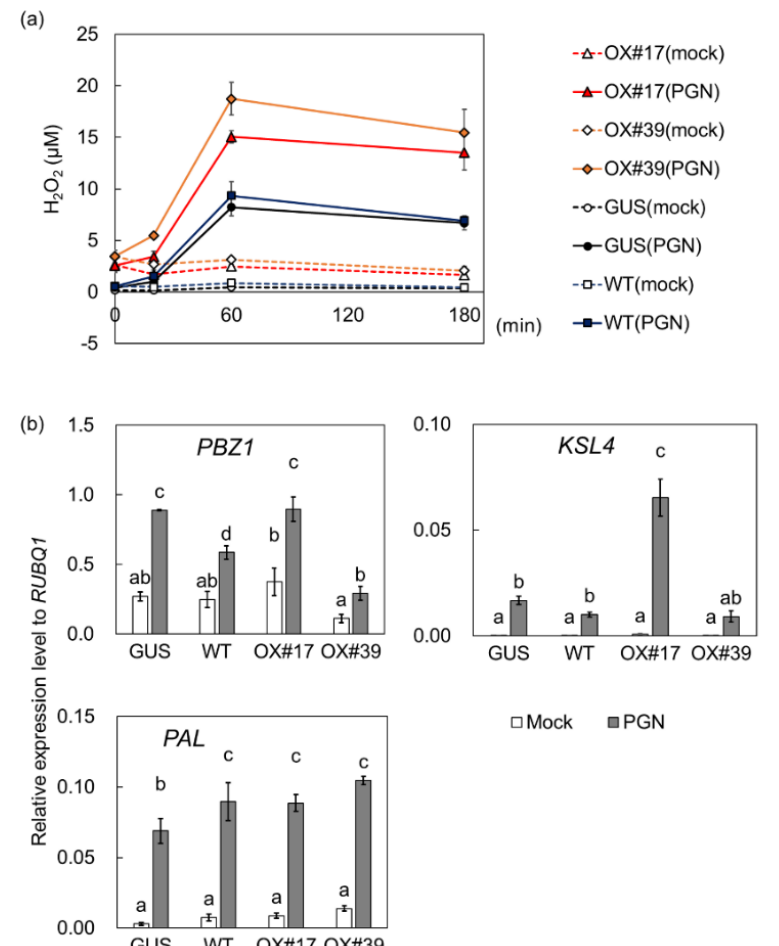
Figure 3. The overexpression of BSR1-HPB enhanced peptidoglycan-induced oxidative bursts in suspension-cultured rice cells. Cells treated with peptidoglycan were analyzed for H 2 O 2 production accompanying oxidative bursts ( a ) and the transcript levels of defense-related genes ( b ). Values are presented as the means ± standard deviations of three biological replicates. In ( a ), H 2 O 2 concentrations were measured before treatment and at 20, 60, and 180 min after treatment. The statistical analysis was performed as shown in Figure S2a. Experiments were conducted three times with similar results. In ( b ), the PBZ1 , PAL1 , and KSL4 transcript levels were normalized against the RUBQ1 internal control levels. Experiments were conducted two times with similar results. Different letters indicate